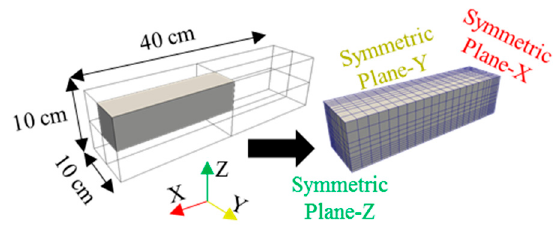
Figure 10. FE model of one-eighth of the 400 × 400 × 200 mm 3 prismatic specimen.